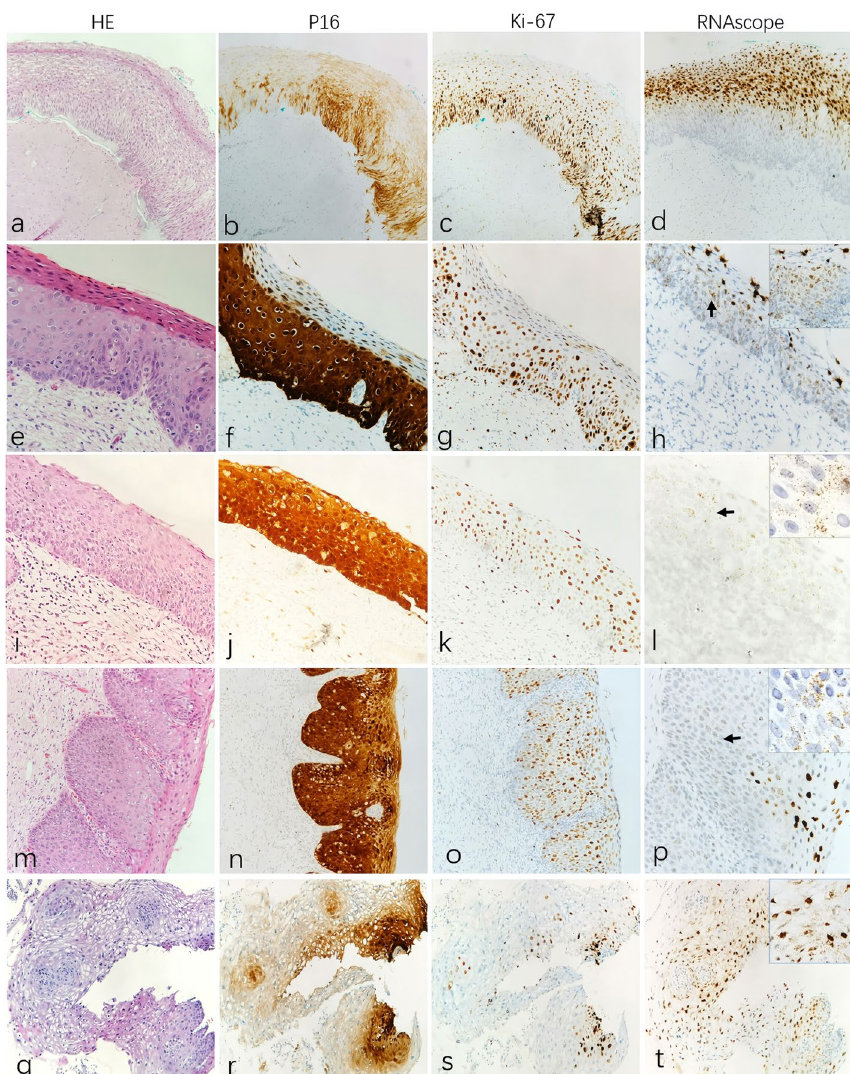
Fig. 1 The Location Character of HPV RNA in different CIN grades in the control group. Row1 ( a - d ): HR-HPV RNA in CIN1 lesion (P16 show diffuse clustered expression pattern in nuclei/cytoplasmic, staining areas is mainly located on the surface epithelium ( d ). Row2 ( e – h ): HR-HPV RNA in CIN2 lesion (P16 and Ki67 ) show nucleus/cytoplasmic dot positivity in the basal and parabasal layer, and combined with diffuse cluster + + nuclei positivity on the surface epithelium ( h , arrow). Row3 ( i - l ) and Row4 ( m - p ): HR-HPV RNA in CIN3 lesion (P16 full-thickness nucleus/cytoplasmic scattered staining(l, arrow) or combined with a clustered nuclei staining on the superficial cells (bottom right of image p ). Row5 ( q - t ): The expression pattern of LR-HPV RNA in CIN1 lesion (P16 pattern in nuclei/cytoplasmic, staining areas is mainly located on the surface epithelium ( t ,